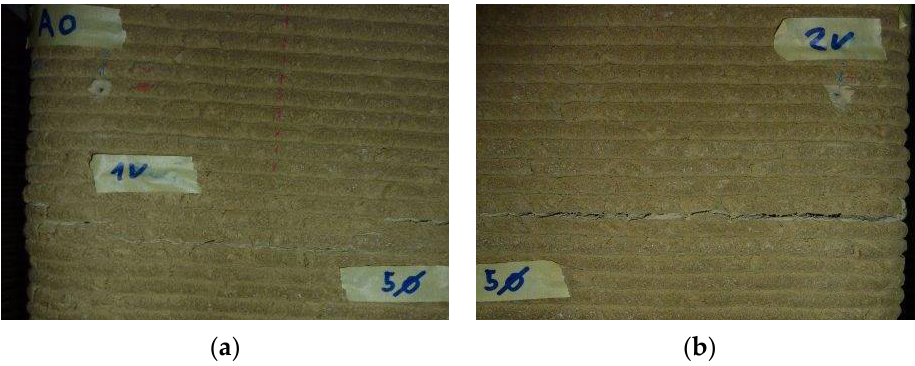
Figure 10. Failure mechanisms on the two short sides: ( a ) side located to the left of the operator, extending between edge 1 (left) and edge 2 (right); ( b ) side located to the right of the operator, extending between edge 3 (left) and edge 4 (right).